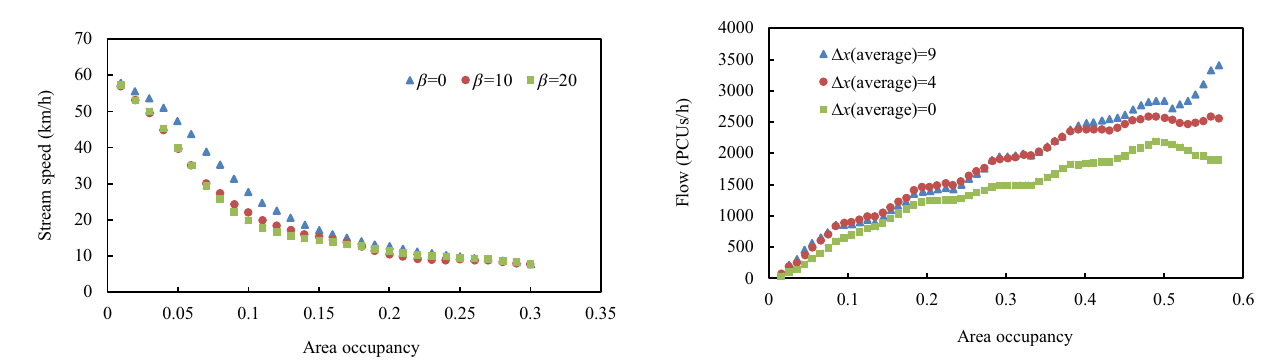
Fig. 12 Relationship between area occupancy and stream speed for different values of b and only car scenario using the PP-CA model